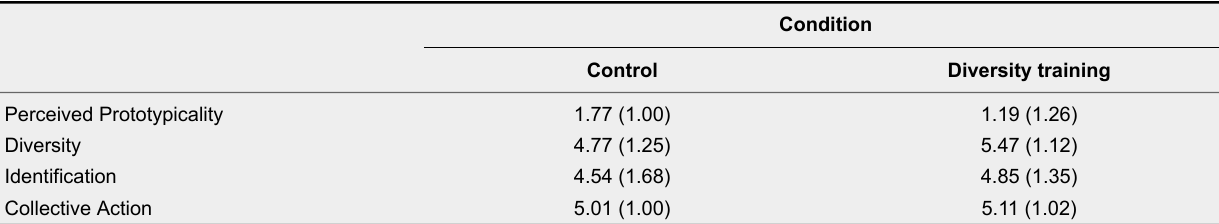
Effect of Diversity Training on Outcomes at Measurement Point